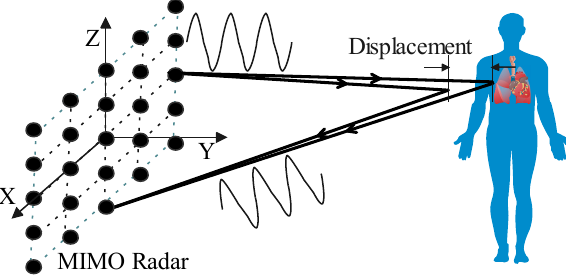
Figure 1. Schematic diagram of vital signs detection by MIMO radar